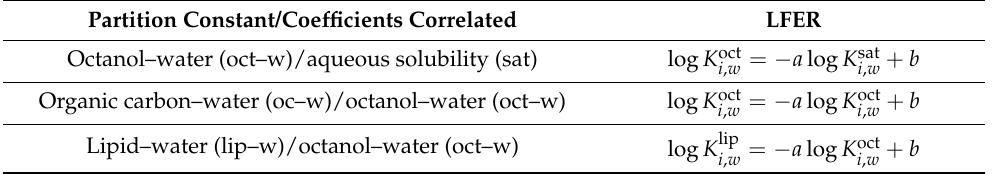
Table 3. Examples of simple one-parameter linear free energy relationships (LFERs) proposed for connecting partition constants in various two-phase